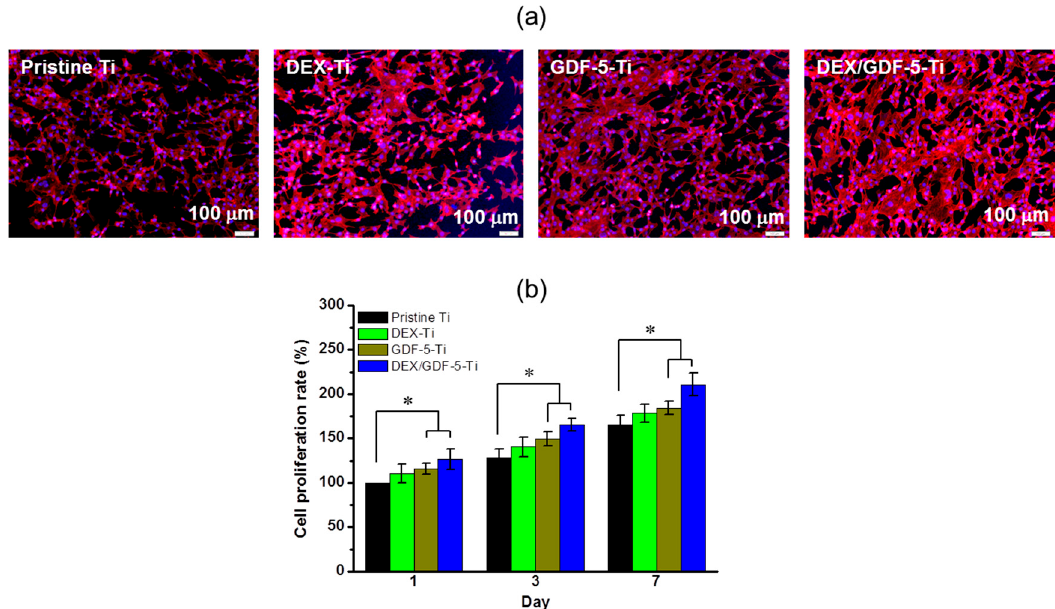
Figure 5. ( a ) Fluorescence images and ( b ) in vitro cell proliferation rates of MC3T3-E1 cells cultured on pristine Ti, DEX–Ti, GDF-5–Ti and DEX/GDF-5–Ti disc samples. The images and rates were examined by fluorescence microscopy at days 14, and cell counting kit-8 (CCK-8) assay at days 1, 3 and 7, respectively. The white bar indicates 100 µm.